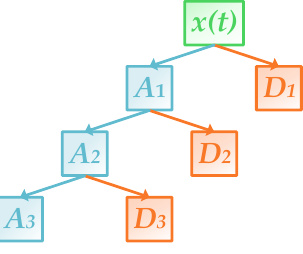
Figure 3. A three-level decomposition of discrete wavelet transform (DWT) using Mallat algorithm.